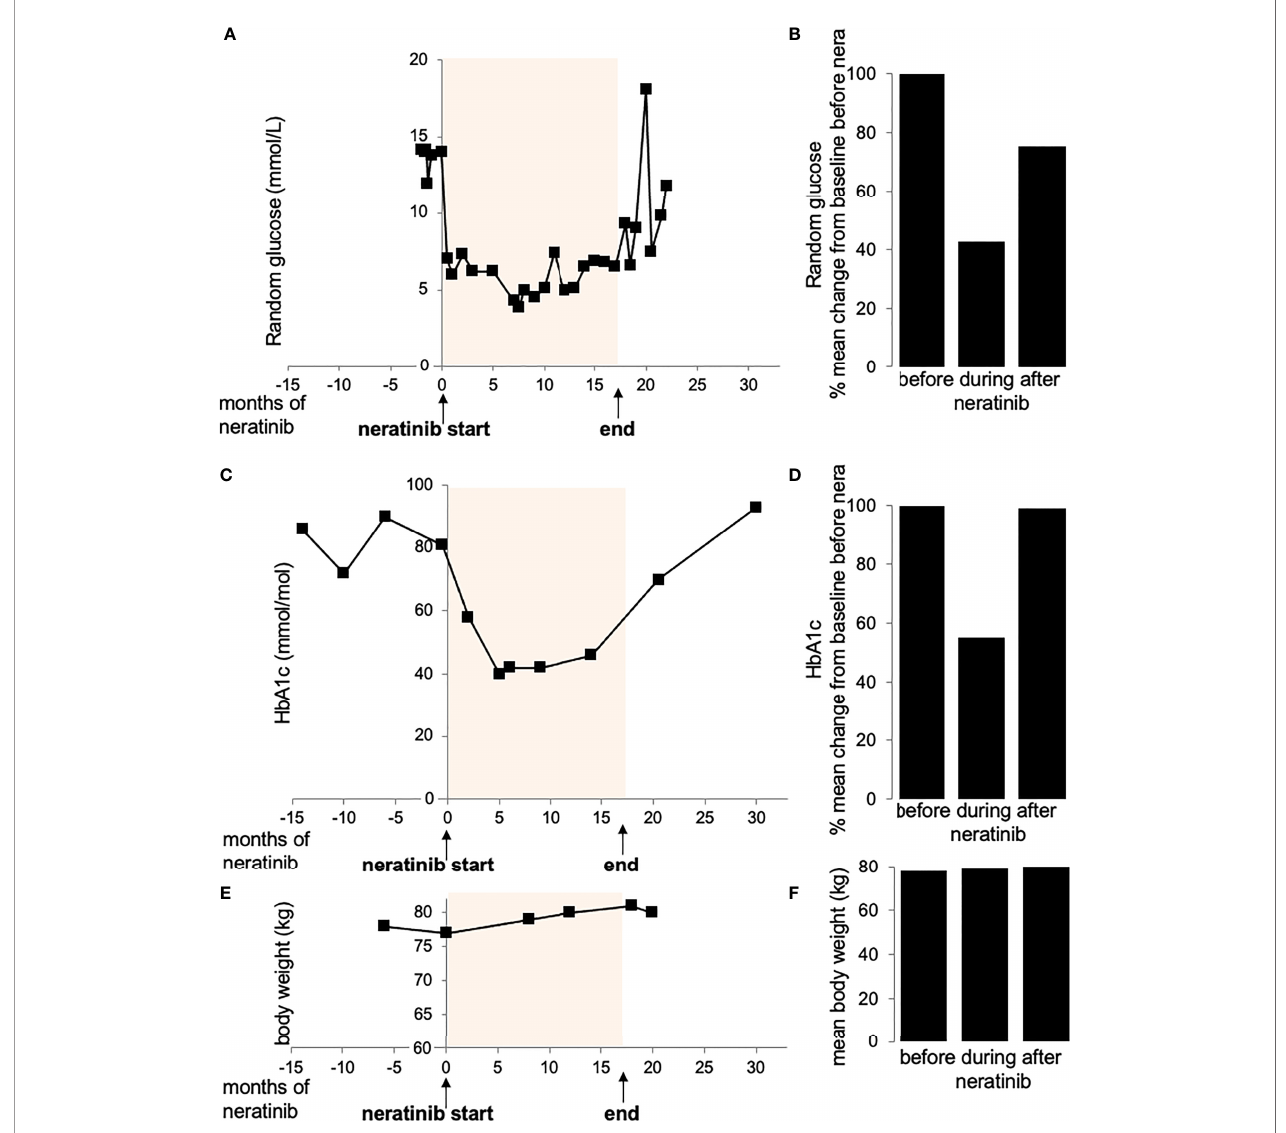
FIGURE 1 | Random glucose (A, B) , HbA1c (C, D) and body weight (E, F) values before, during and after treatment with neratinib. (Figure created using smart servier medical art under